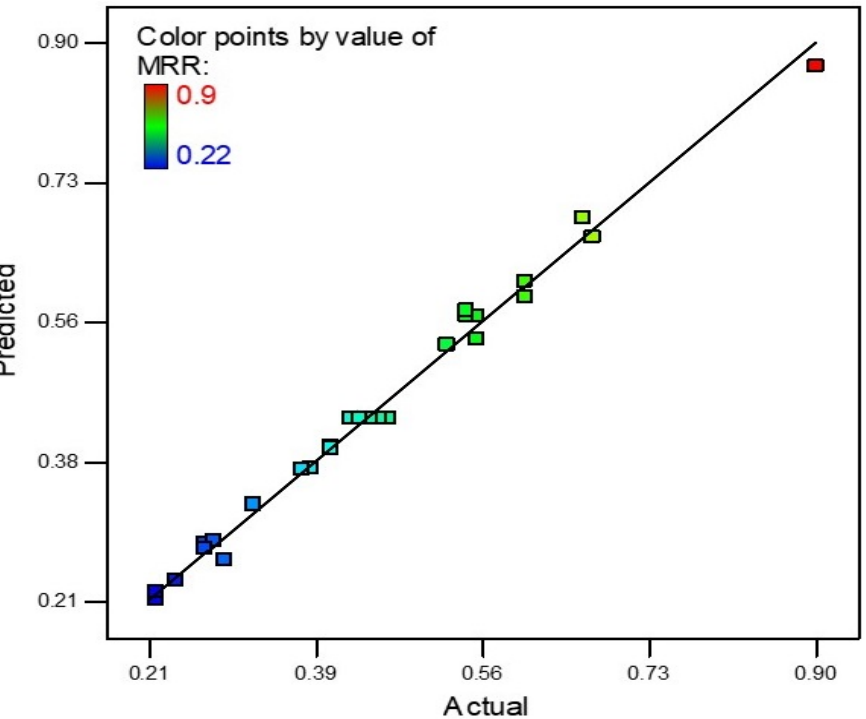
Figure 2. Predicted vs. actual values of MRR.